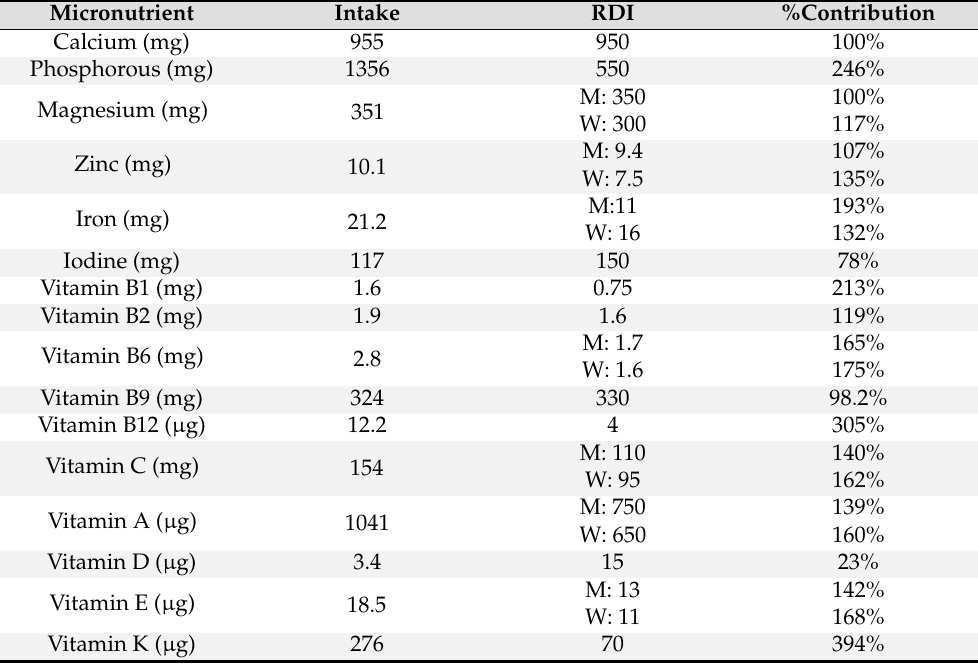
Table 4. Micro-nutrients’ analysis according to estimated real food